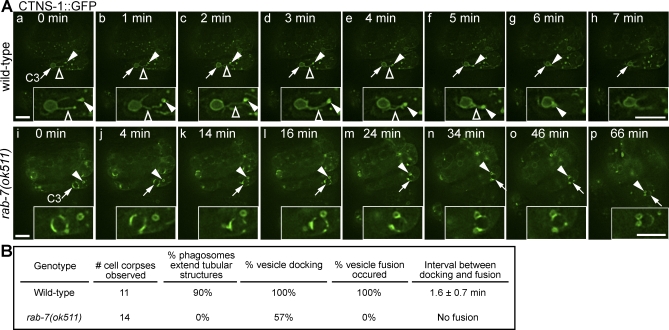

rab-7 Mutants Are Defective in the Extension of Tubular Structures from Phagosomes and in the Recruitment and Fusion of Lysosomes to Phagosomes(A) As shown in Videos S3 and S4, time-lapse recordings of a CTNS-1::GFP–labeled lysosome particle (white arrowheads) being delivered to C3 phagosome (arrows) in wild-type (a–h) and rab-7(ok511) (m−z−) (i–p) embryos that express Pced-1 ctns-1::gfp. Open arrowheads indicate tubular structures. Scale bars represent 5 μm.(B) Quantitative data deduced from multiple time-lapse recording experiments similar to (A) that score the defects in the recruitment and fusion of lysosome to phagosomes in rab-7(ok511) (m−z−) embryos.